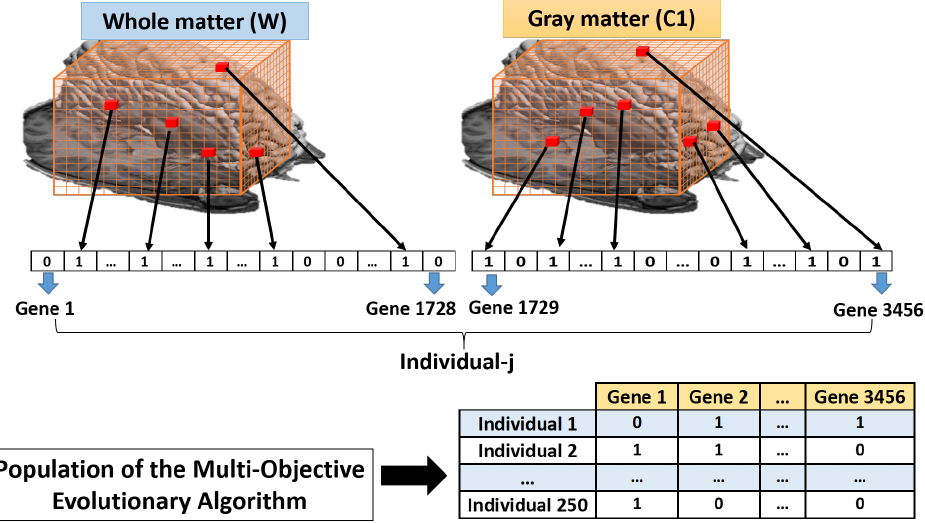
Figure 6. Binary coding used by the MOE algorithm, with the aim of selecting the most relevant VOI of the brain (both in gray and complete matter), and these regions being used for the construction of an accurate multi-class